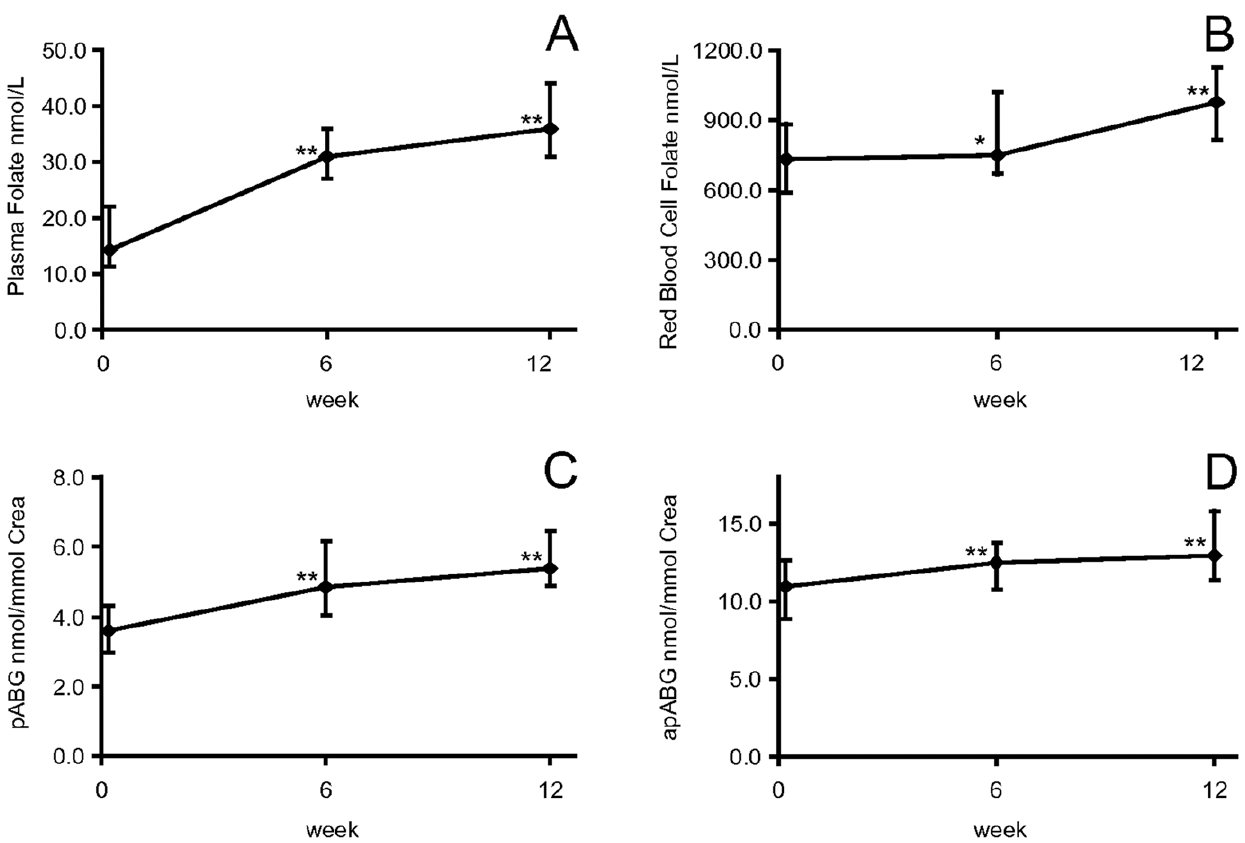
Figure 4. Time course of plasma, red blood cell folate, urinary pABG and apABG during folic acid supplementation. Time course of the median concentrations (error bars=inter quartile range (IQR)) of plasma folate (nmol/L) (A), red blood cell folate (nmol/L) (B), pABG (nmol/mmol creatinine) (C) and apABG (nmol/mmol creatinine) (D) during folic acid supplementation. Significant changes from baseline: *: p=0.005 and **: p # 0.001 (Wilcoxon’s test). (Figure 3D and 3F; Table 2). The correlation between RCF and